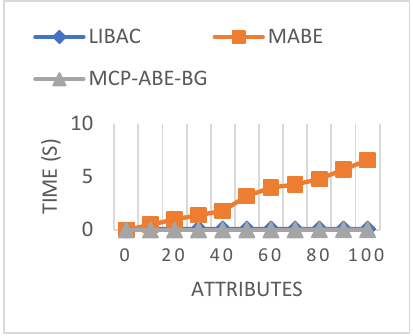
Figure 8. Decryption time.